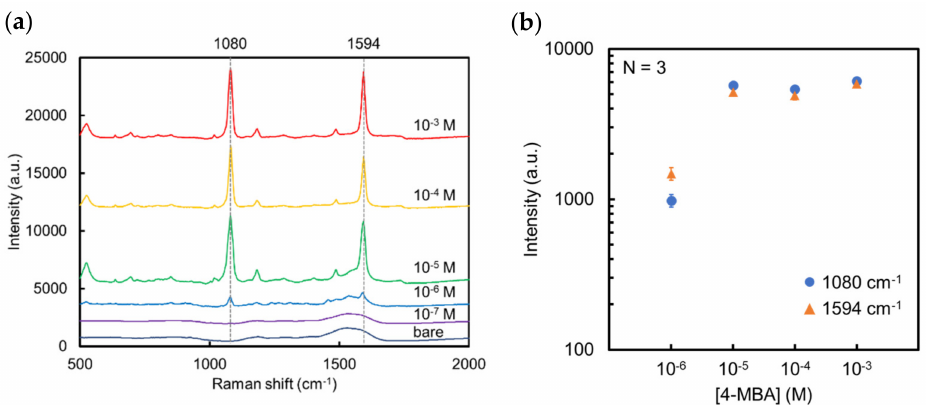
Figure 5. ( a ) SERS spectra of 10 − 7 –10 − 3 M 4-MBA on Au NCA and bare Au NCA. ( b ) Concentration dependency for 4-MBA at 1080 and 1594 cm − 1